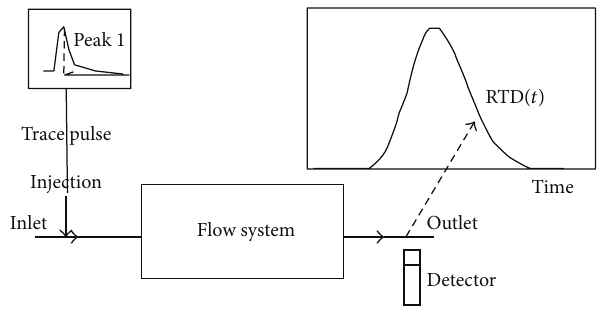
Figure 2: Principle measurement of RTD by Stegowski and Furman (2004)